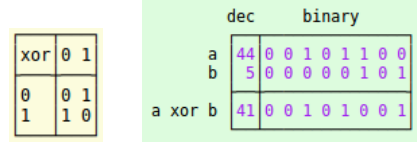
1.1 Bitwise Exclusive Or (xor) The vector-to-raster conversion method heavily relies on the bitwise exclusive or operator. It is applied to the numerical values of polygons/polyhedra in the input, which appear as pixel/voxel values in the output. The operator, denoted a xor b when applied to values a and b , is illustrated in Fig. 2. Here the range of values is assumed to be 0-255 (8 bits), but the principle is the same for larger ranges (16, 32 or 64 bits). Bitwise Exclusive Or is a primitive operation (instruction) in the CPU of any computer, and is therefore executed at the highest speed possible.